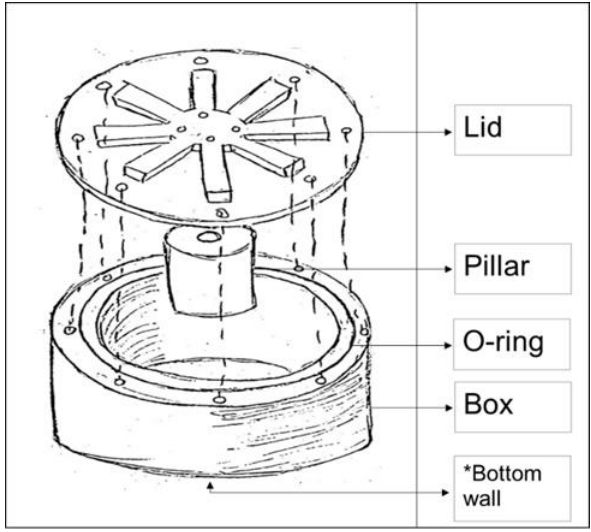
Figure 2. Concept sketch of the WCH design.